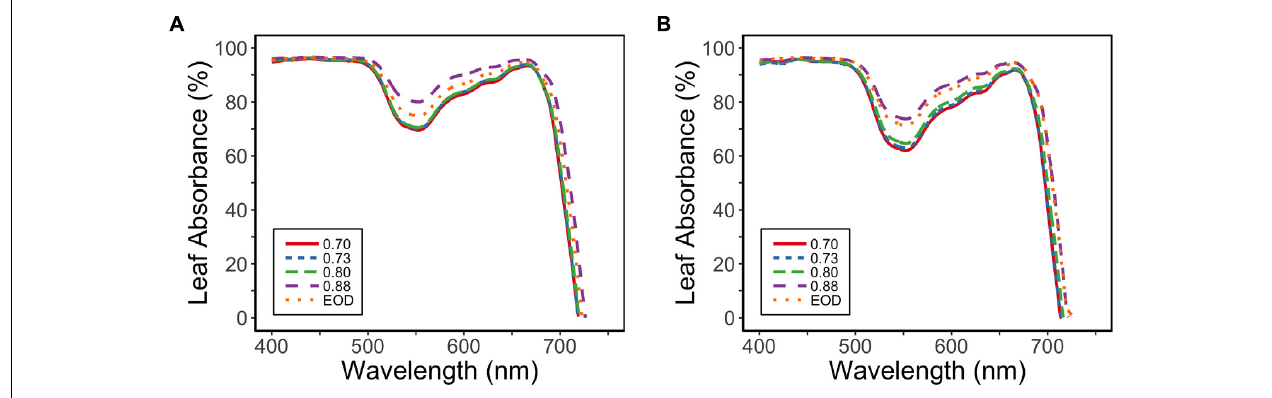
FIGURE 4 | Absorbance spectra for tomato leaves in relation to four levels of PSS and an EOD-FR treatment in EXP1 (A) and EXP2 (B) ( n = 2). Plants had been grown for 4 weeks at the different light treatments.